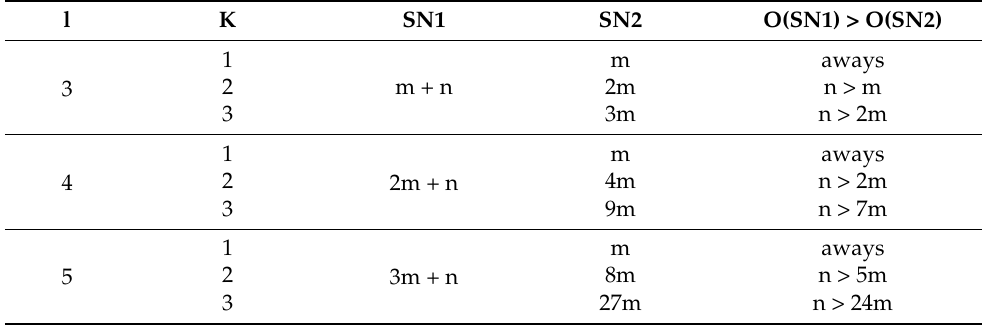
Table 4. The comparison of geospatial service web search space